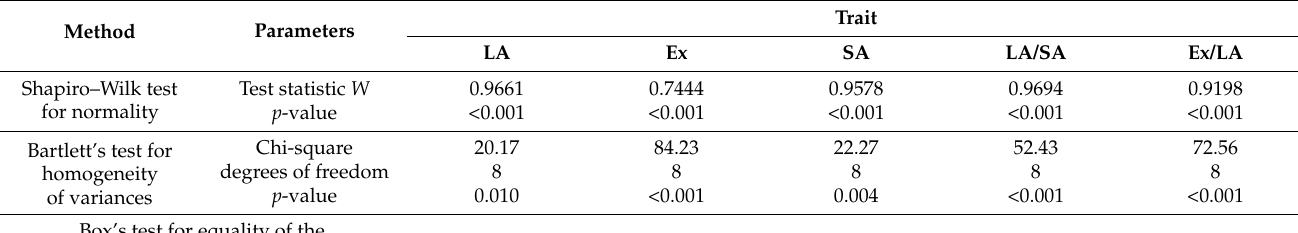
Table 2. Results of Shapiro–Wilk’s normality test and Bartlett’s test for particular traits as well as Box’s M test for equality of the covariance